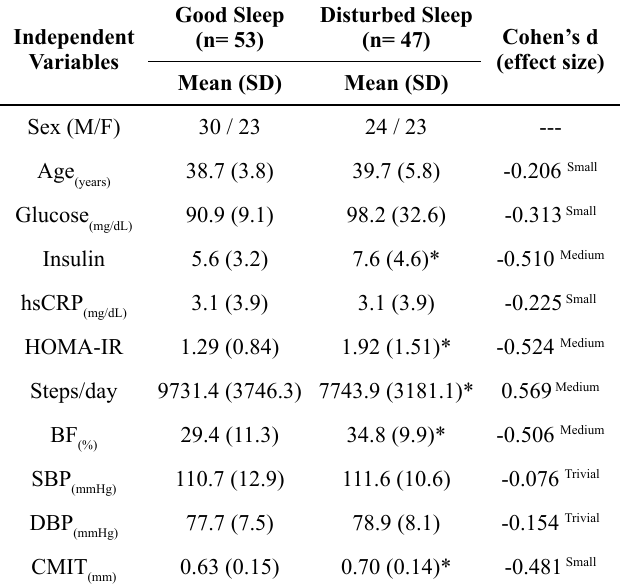
Table 1. General characteristics of the sample stratified by sleep qual - ity among young adults.